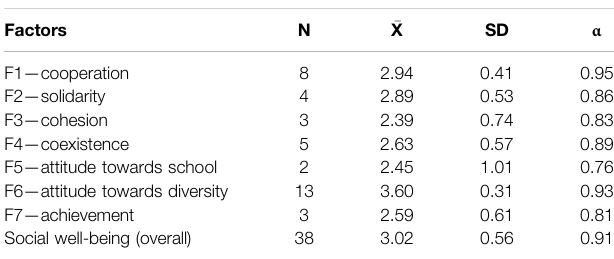
TABLE 4 | Overall results by